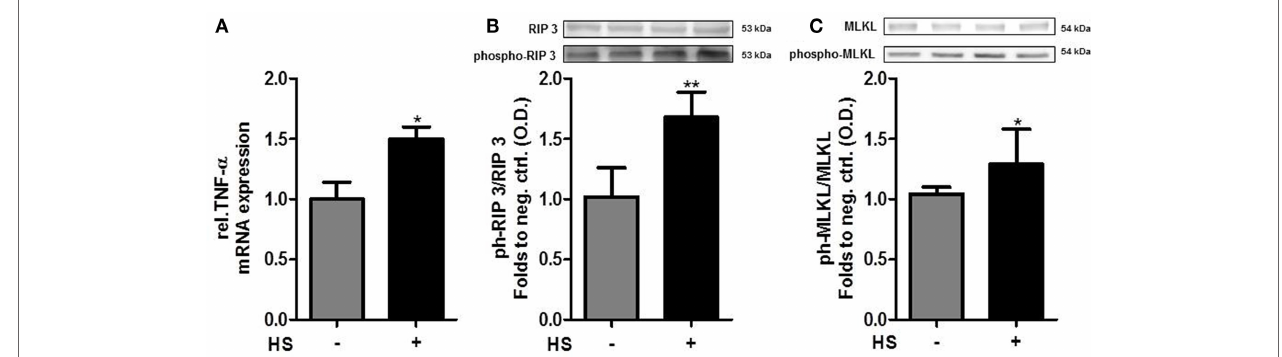
FIGURE 5 | Heparan sulfate induces necroptosis in cardiomyocytes. (A) Relative caspase 3 mRNA expressions of HL-1 cells exposed to HS for 16h were analyzed by quantitative real-time PCR, compared to unstimulated cells. Expression was normalized to reference gene S7 and normalized to unstimulated cells. (B) HL-1 cells exposed to 10 μ g/ml HSs for 16h showed a significant increase in phosphorylation of RIP3 and (C) MLKL compared to unstimulated cells. Protein expression was normalized to unstimulated cells. The data represent the mean (cid:6) SD of triplicate samples for three independent experiments. HS, heparan sulfate; RIP, receptor-interacting protein; MLKL, mixed lineage kinase domain-like; TNF- α , tumor necrosis factor alpha; * p < 0.05, ** p < 0.01 vs. unstimulated cells.